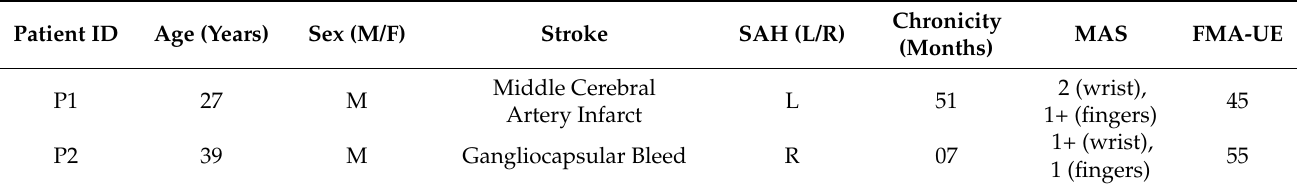
Table 1. Demographic details of the two patients participated in the